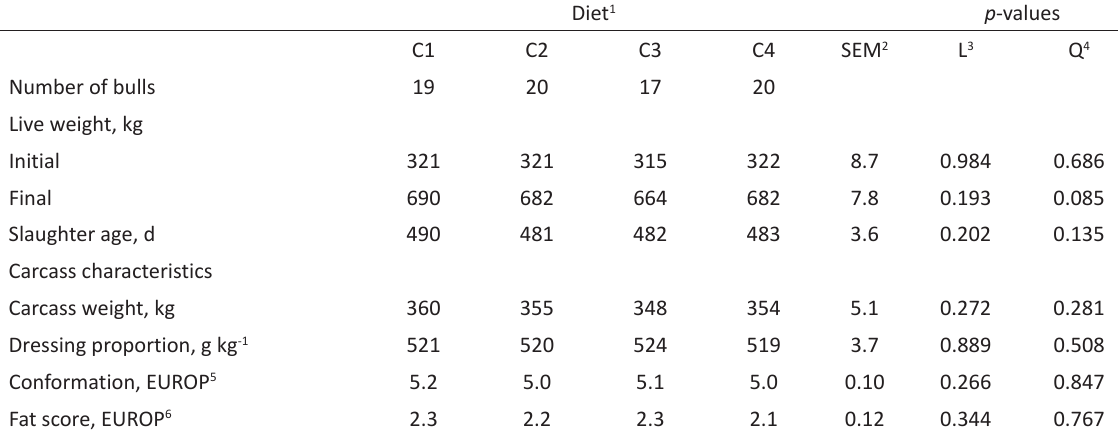
Table 3. Live weights and carcass characteristics of the bulls